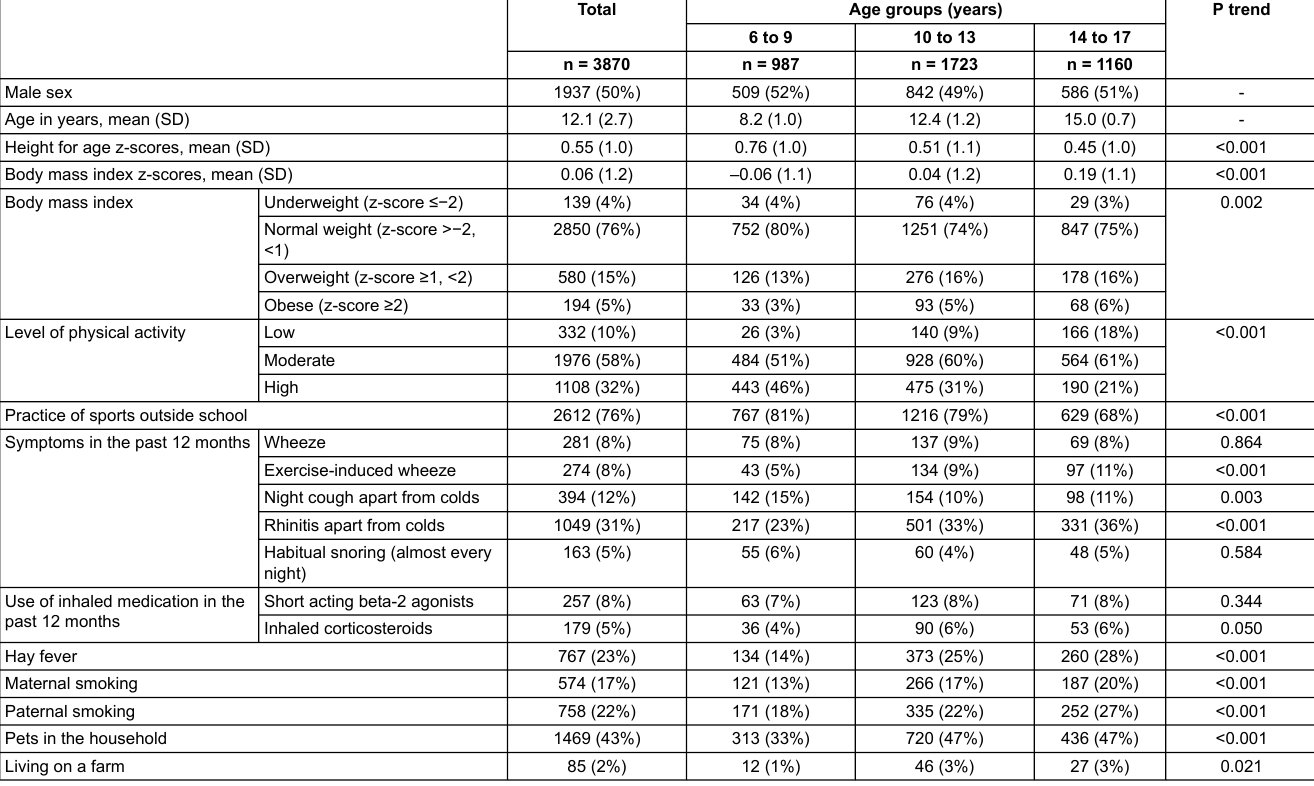
Table 2: LuftiBus in the School (LUIS) study: characteristics of the study